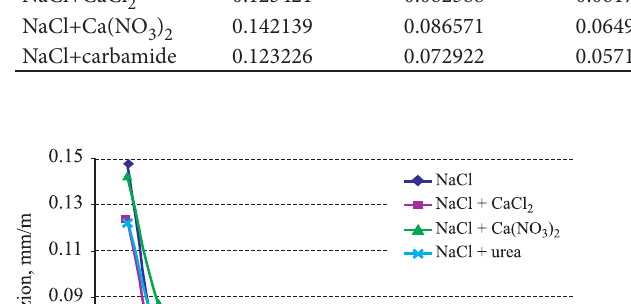
Table 3. The obtained results of corrosivity of the study solutions Composition of the study solution